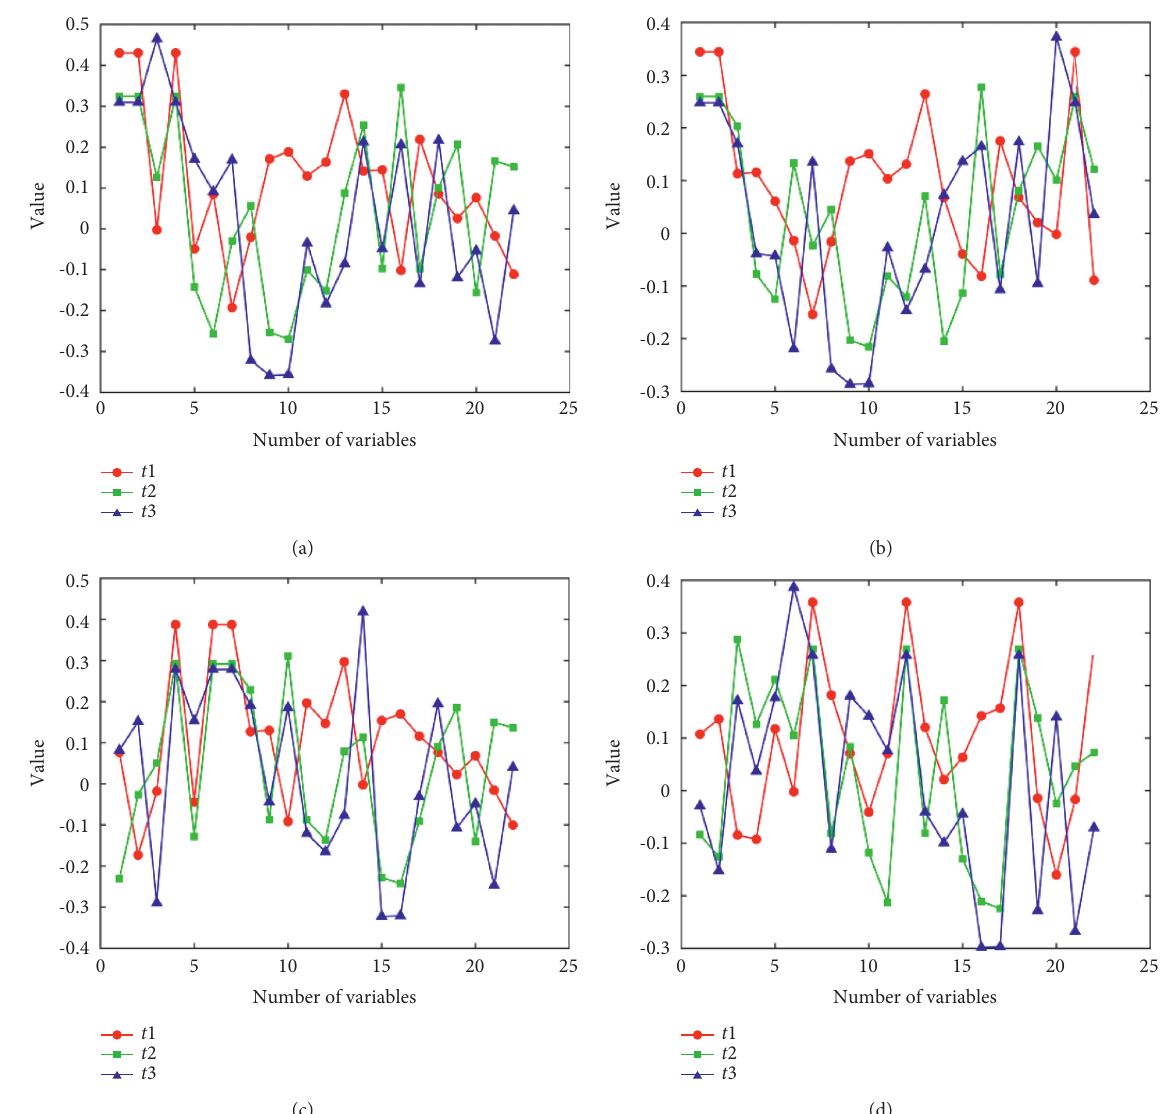
Figure 4: Standardized factor score: (a) University 1; (b) University 2; (c) University 3; (d) University